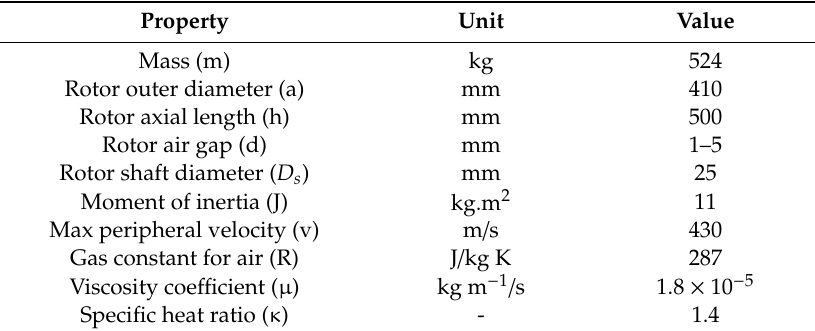
Table 1. Flywheel specifications and air